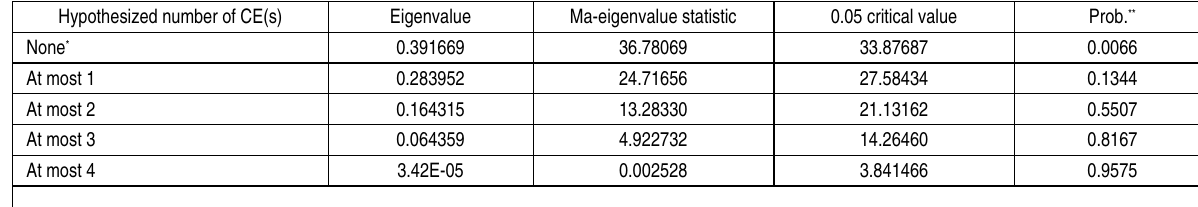
Table 4. Unrestricted cointegration rank test (maximum eigenvalue) results